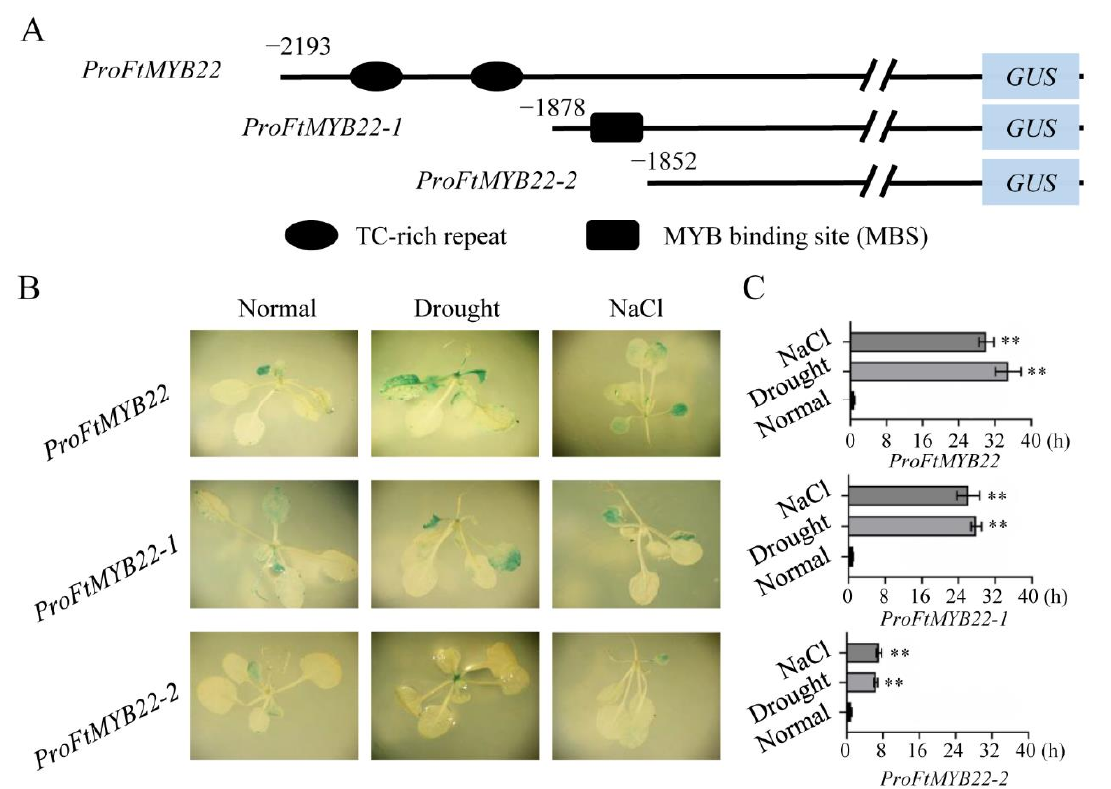
Figure 3. Response analyses of ProFtMYB22 to water deficit and salt stress. ( A ) Truncated model of ProFtMYB22 . ( B ) GUS staining in ProFtMYB22 transgenic plants under abiotic stress as indicated. ( C ) Expression levels of GUS in ProFtMYB22 transgenic plants following indicated treatments. Normal: the normal condition. Data are presented as mean and SD values of three independent experiments. Error bars represent standard errors. ** means extremely significant difference at p < 0.01 level.